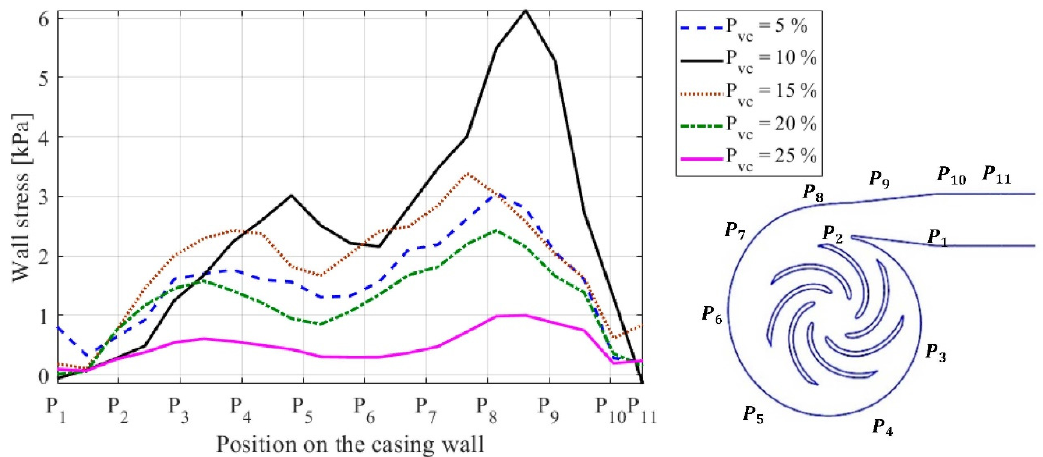
Figure 9. Wall stress profiles along the casing wall with different values of volumetric concentration of the solid particles.